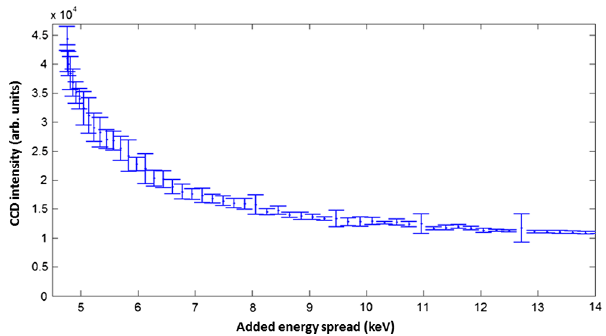
FIG. 10. OTR intensity measured immediately downstream of BC1 plotted vs laser heater-added energy spread for a 500 pC bunch charge compressed by a factor 10 in BC1.